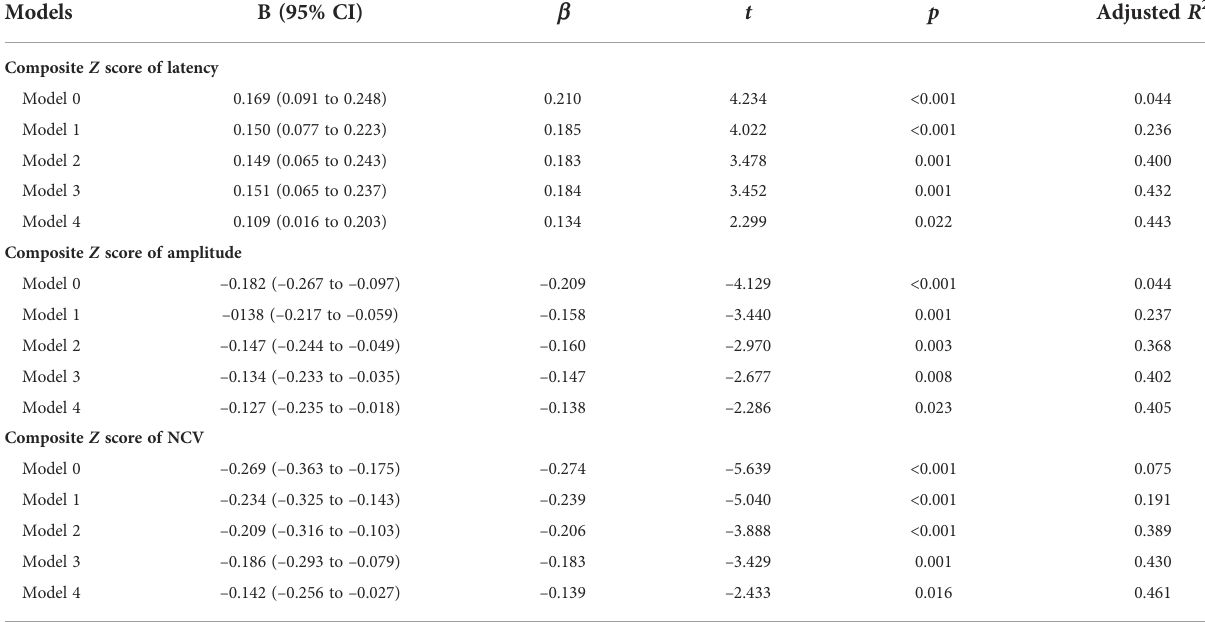
TABLE 2 Impacts of plasma D-dimer on outcomes of nerve conduction indices by multivariable linear regression analysis. Models